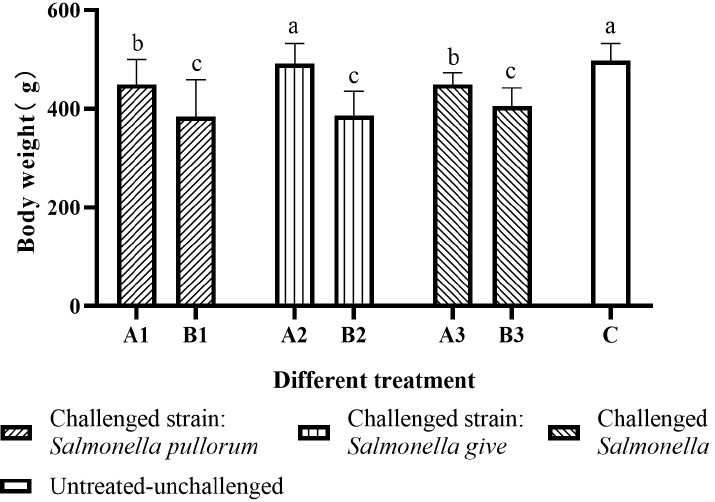
Figure 2. Body weight of birds in different groups. The means with different letters denote a significant difference ( p < 0.05).